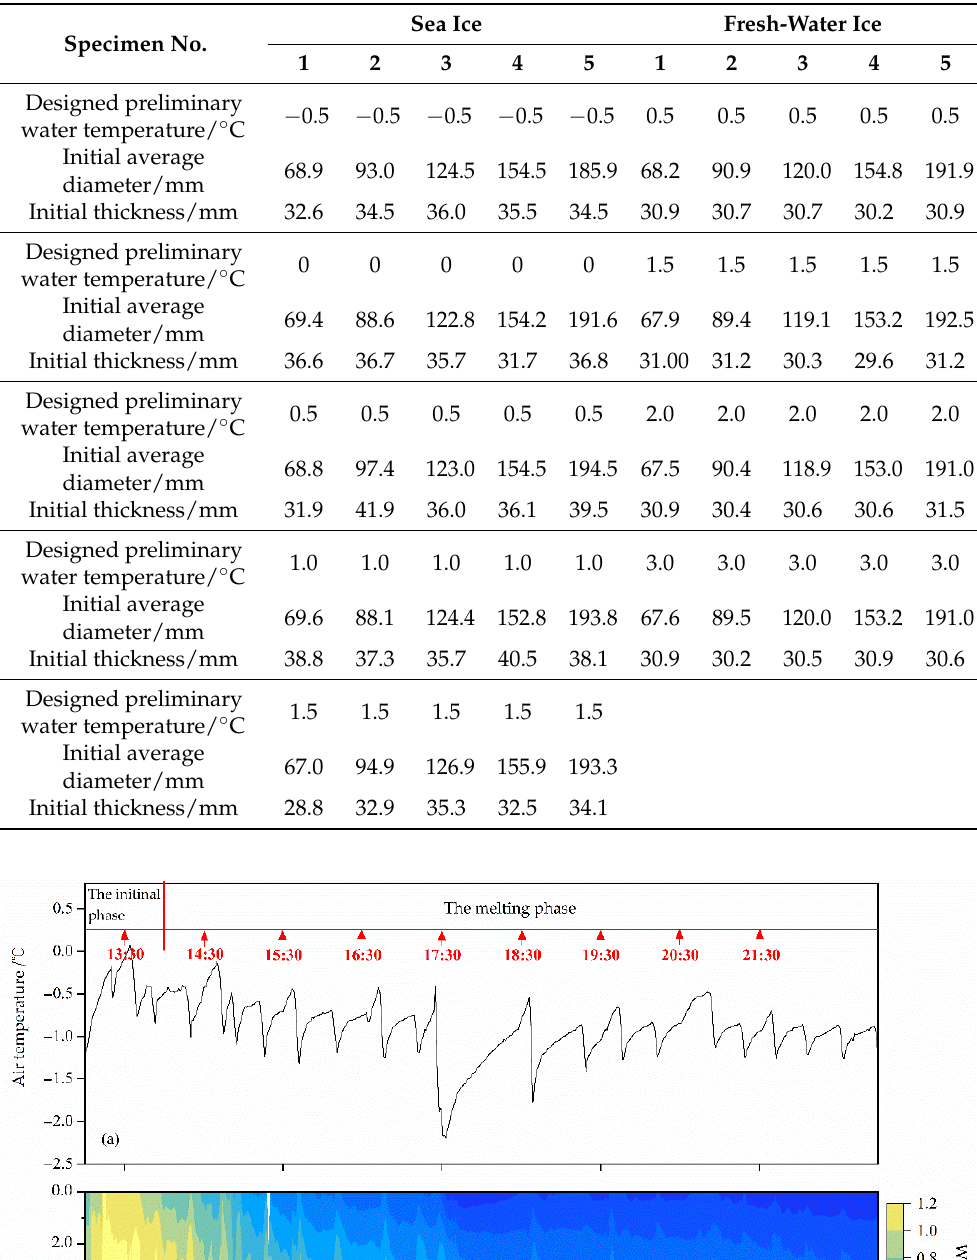
Table 1. Preliminary parameters of the ice samples.